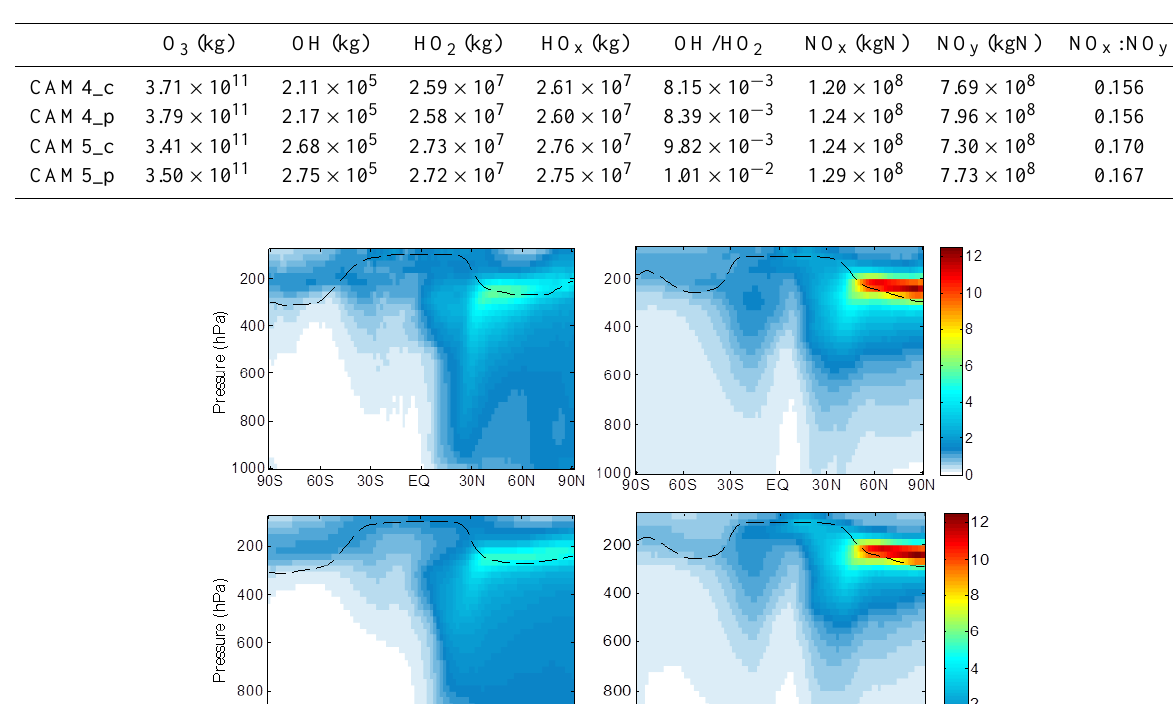
Table 1. Annual tropospheric mean burden of HO x , NO x , gaseous NO y and the ratios of OH:HO 2 and NO x :NO y in both CAM5 and CAM4 for both the control run (_c) and aviation NO x -perturbed run (_p).